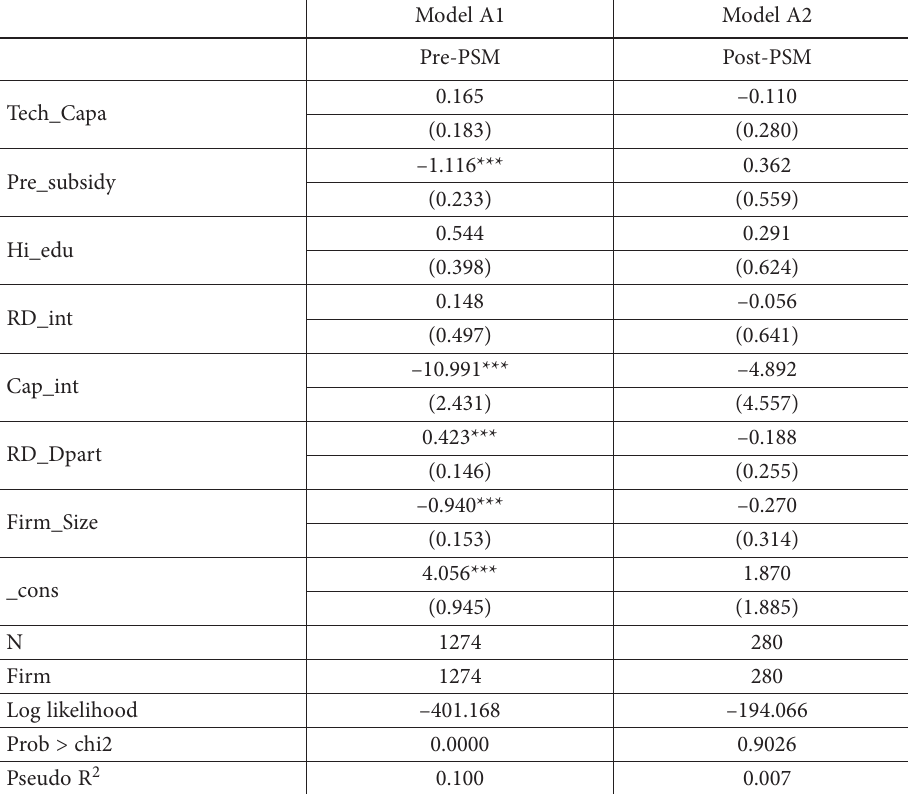
Table A.3. The Probit Regression for the PSM